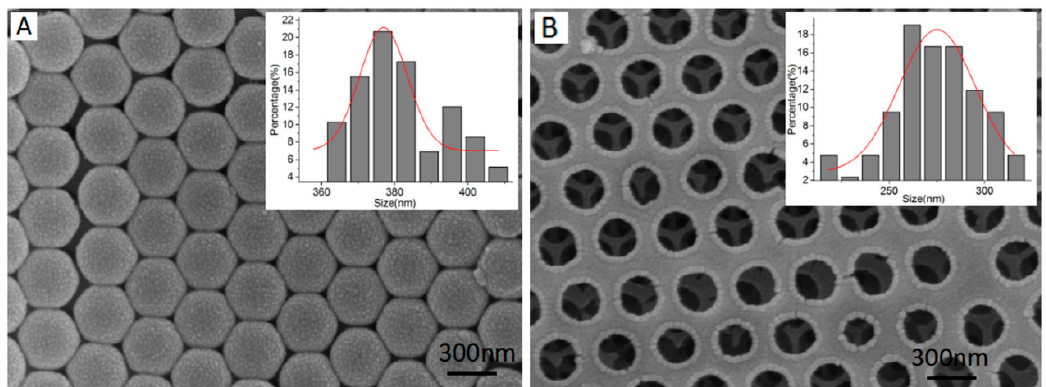
Figure 13. Scanning electron microscope (SEM) images of: ( A ) packed SiO 2 arrays; ( B ) MIP-based inverse opal as a result of the infiltration of the pre-polymerization mixture, polymerization and chemical etching. Insets: particle size distributions. Reproduced from [197] with permission of Elsevier.